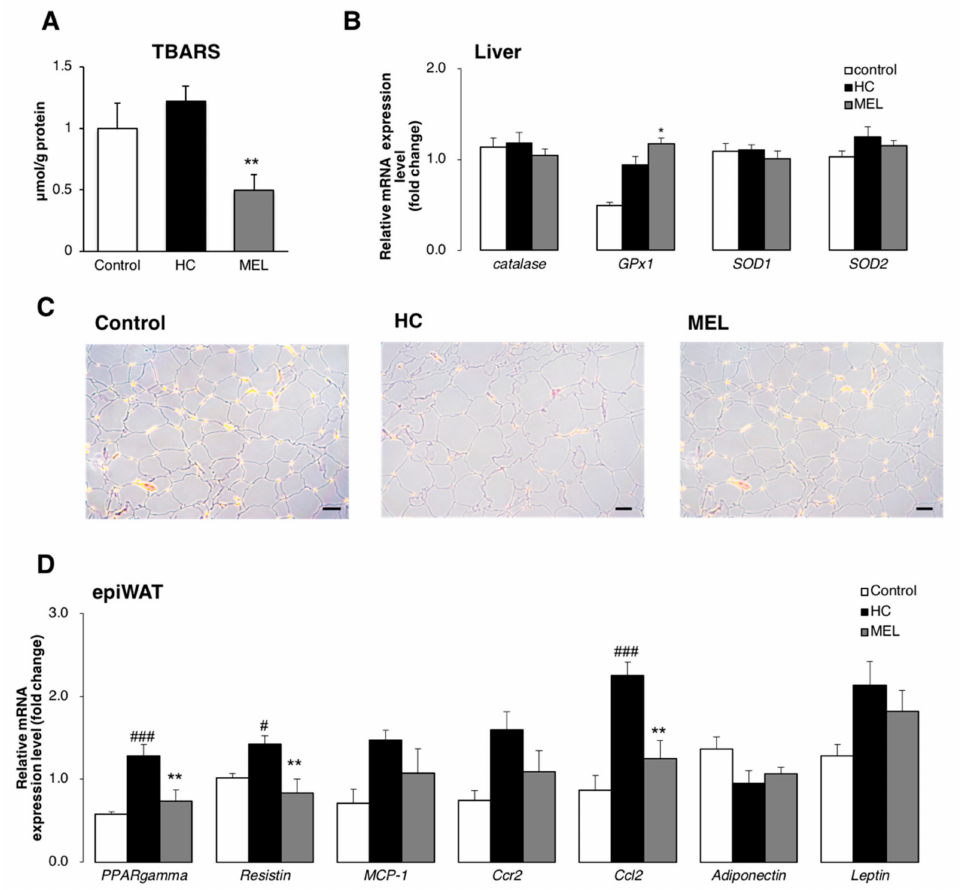
Figure 4. Melon GliSODin ® reduces oxidative stress. Control diet (Control), high-fat and high-cholesterol diet (HC) and high-fat, high-cholesterol + 1% Melon GliSODin ® diet (MEL). ( A ) Levels of oxidative stress marker TBARS in the liver. ( B ) mRNA analysis of liver antioxidants ( C ) H&E staining of epidydimal adipose tissue. Scale bar, 50 µ m. ( D ) mRNA analysis in WAT. Data are shown as mean ± SEM. n = 7 mice per group. Statistical analysis was performed using one-way ANOVA followed by the Bonferroni’s post hoc test. # / * p < 0.05; ## / ** p < 0.01, ### / *** p < 0.001 versus mice fed a HC diet. ( # Significant di ff erences HC versus Control, *Significant di ff erences HC versus